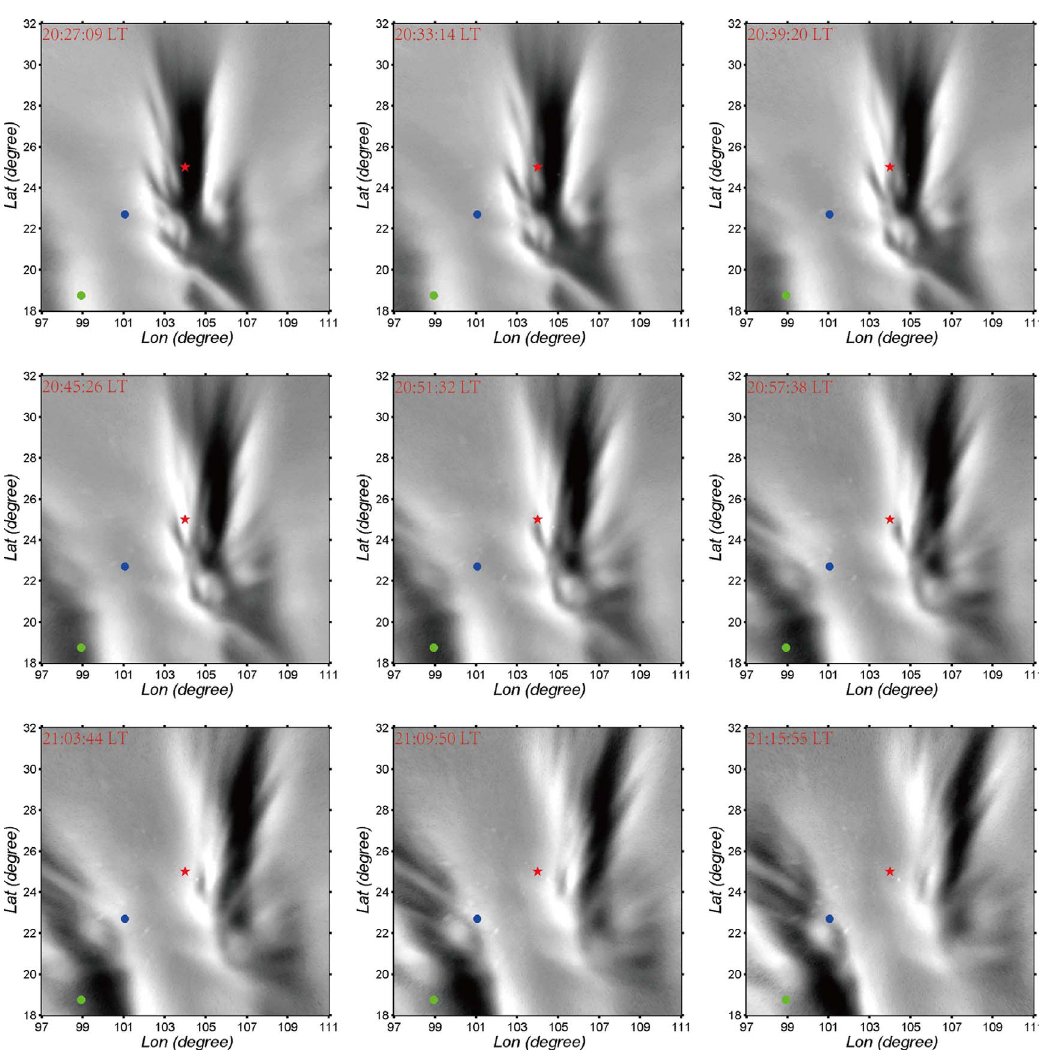
Fig. 6. Similar to Figure 5 but recorded during different local